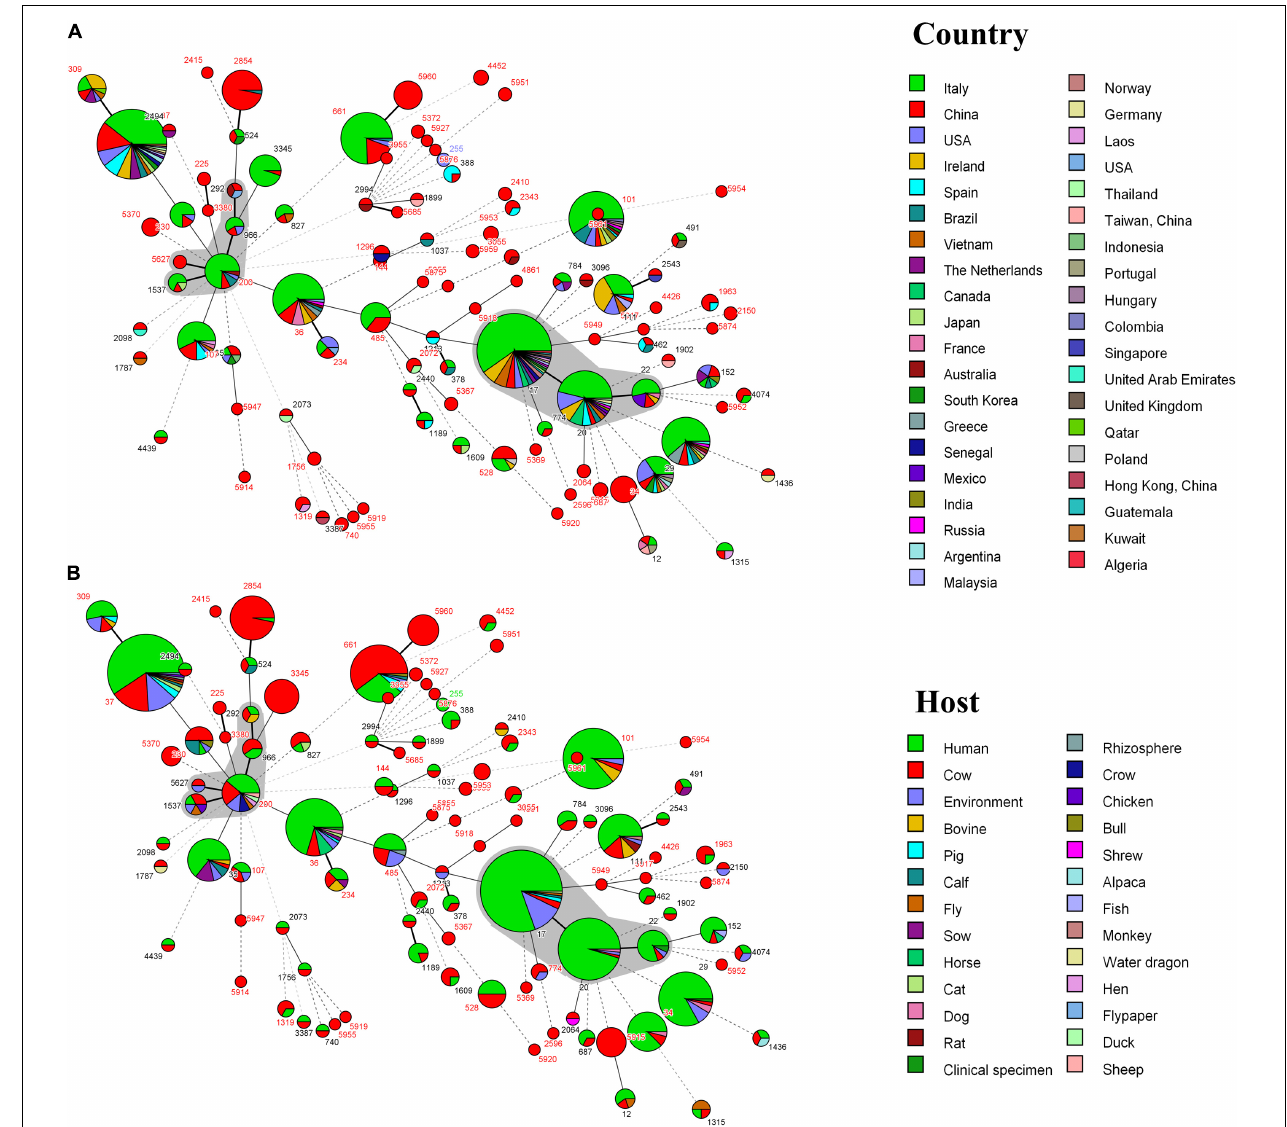
FIGURE 4 | (A) MST of 239 K. pneumoniae in this study and 722 isolates with the same 104 ST from the PubMLST database. Each ST is grouped by different countries. (B) MST of 239 K. pneumoniae in this study and 720 isolates with the same 104 ST from the PubMLST database. Each ST is grouped by different hosts. The gray area represents a clonal complex. One allele difference is represented by a bold line, two allele differences are represented by a straight line, and three or more allele differences are represented by a dotted